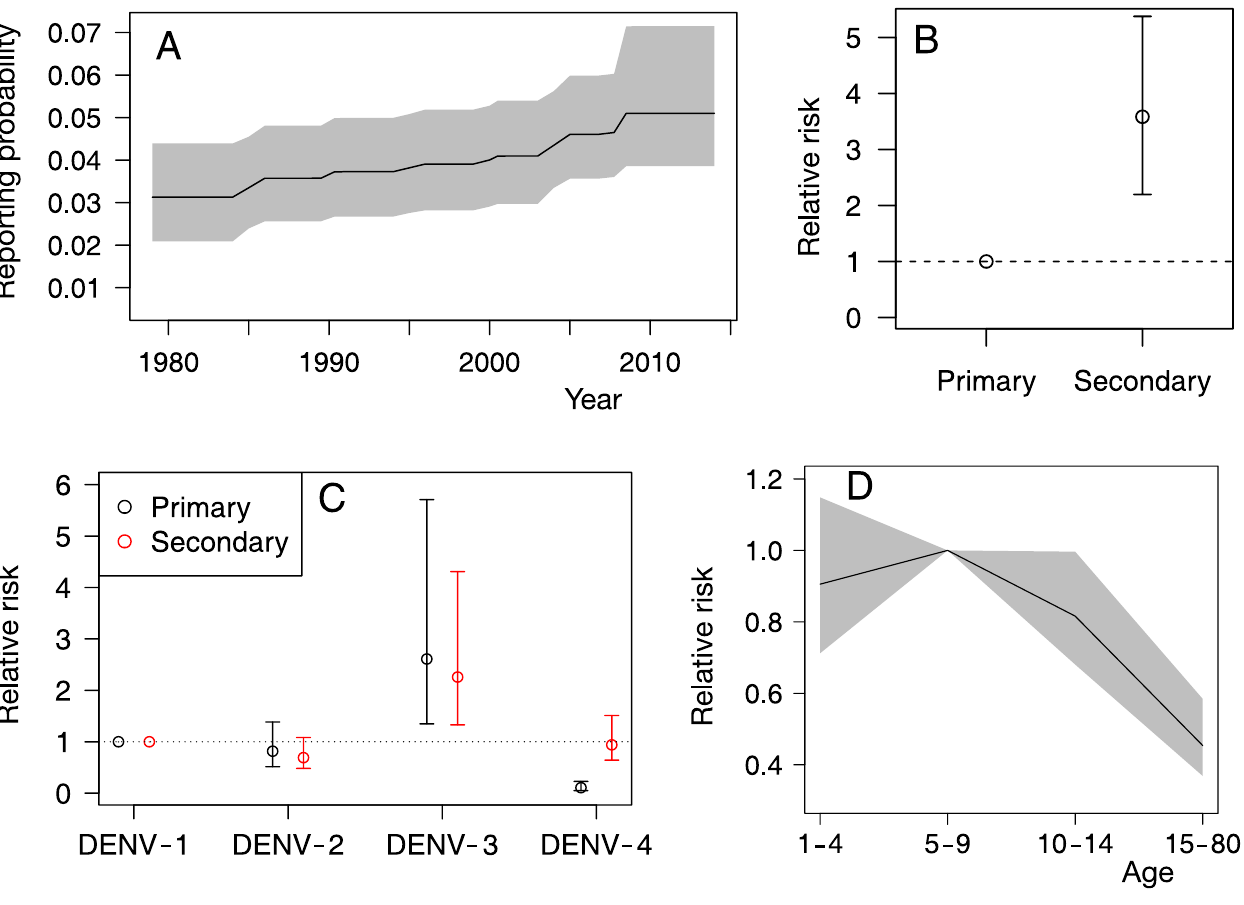
Fig 2. Estimated reporting probabilities (obtained from our model). (A) Reporting probability of primary infections by DENV-1 as a function of time. The grey shaded area shows 95%-CI. (B) Relative strength of the reporting probabilities of secondary infections (DENV-1) compared with primary infections (DENV-1). (C) Comparison of the reporting probabilities for different serotypes, for primary (black circle) and secondary (red circle) infections. The reference group is primary Serotype 1 infection for primary infections and secondary Serotype 1 infection for secondary infections. (D) Variations of the reporting probability with the age group, considering individuals aged 5–9 year old as the reference group. See Section B in S1 Text for the mathematical definitions of the relative risks plotted in these panels.